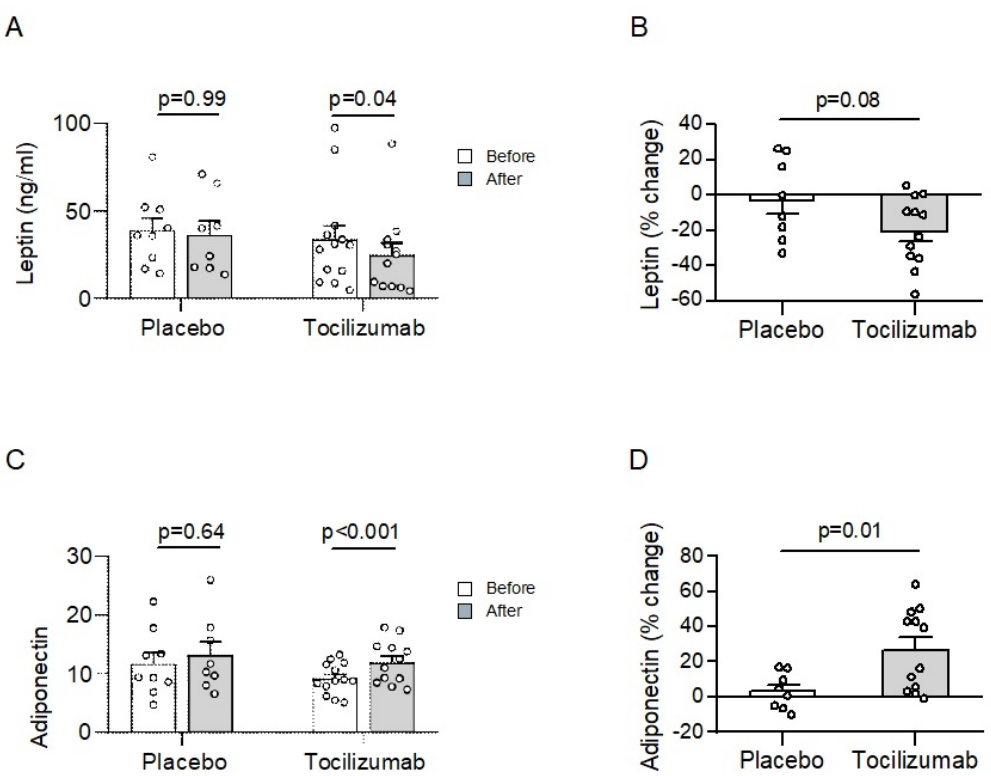
Figure 1. Tocilizumab administration increases adiponectin levels in people with obesity. ( A , B ) Serum leptin and ( C , D ) adiponectin levels were determined in people with obesity, with or without type 2 diabetes, receiving placebo ( n = 9) or tocilizumab administration ( n = 13) before (open bars) and after 12 weeks (grey bars) of administration. Data are displayed as ( A , C ) absolute values or as ( B , D ) percent change over the 12-week administration period. Values are expressed as mean ± standard error of the mean